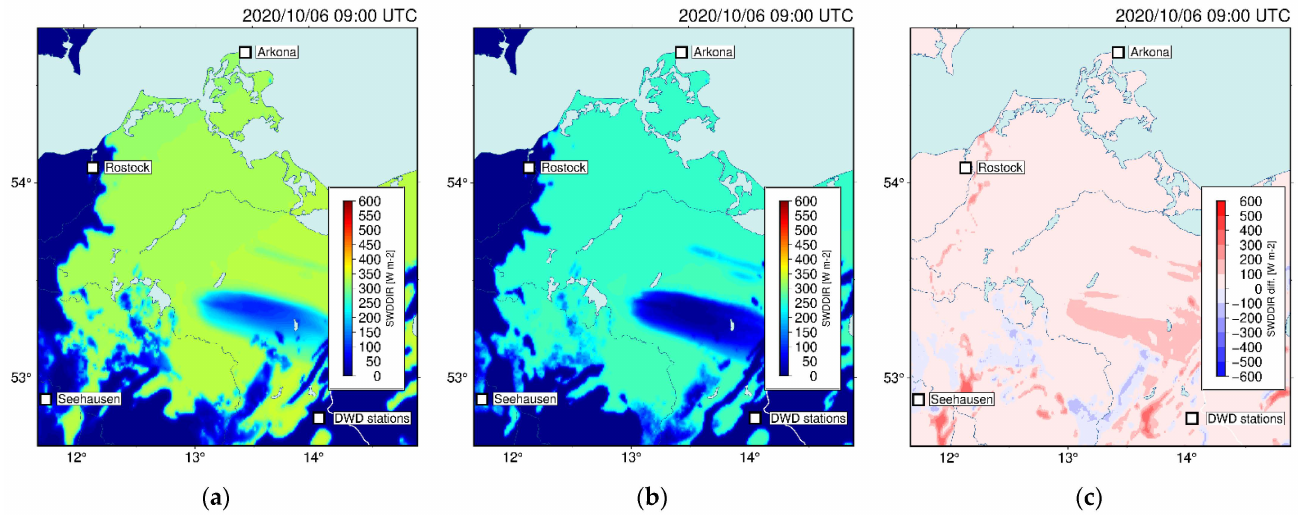
Figure 13. Shortwave surface downward direct irradiance ( SWDDIR ) forecast for 6 October 2020 at 09:00 for: ( a ) WRF-DUDIA; ( b ) WRF-RRTMG; and ( c ) their